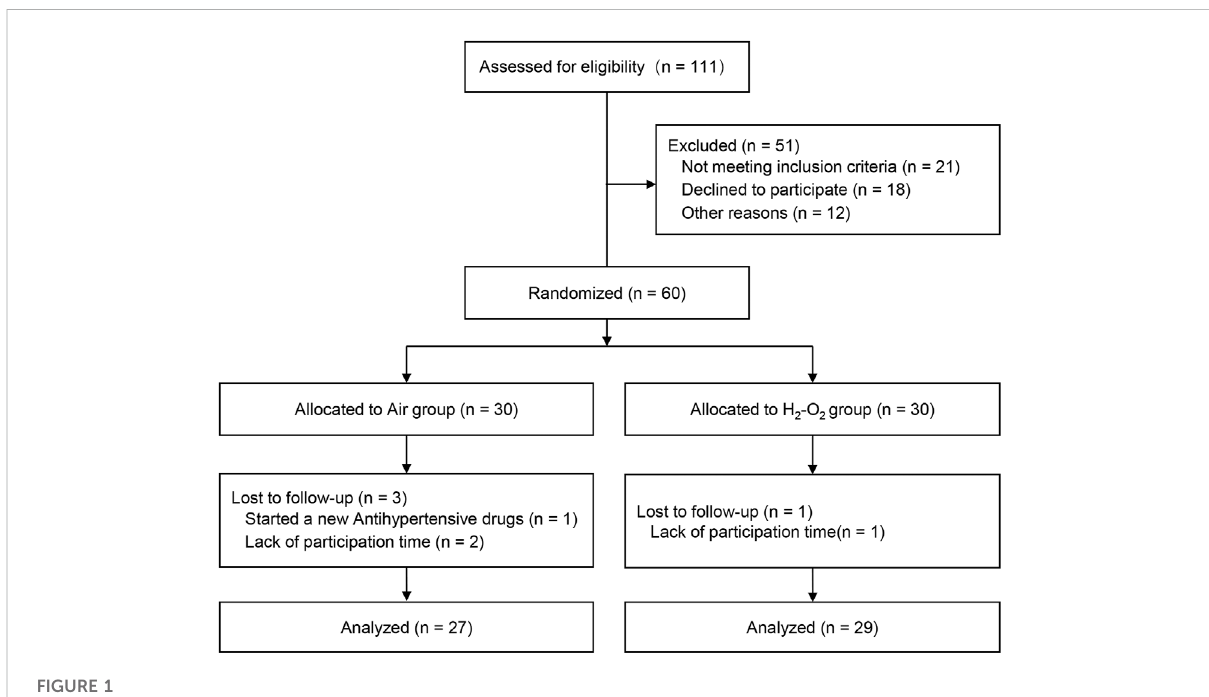
FIGURE 1 Trial fl